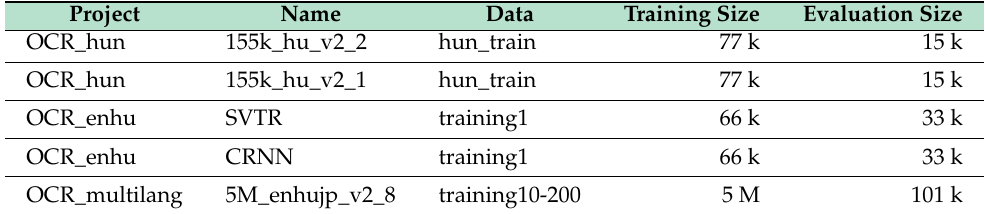
Table 1. Volume information about Dataset and